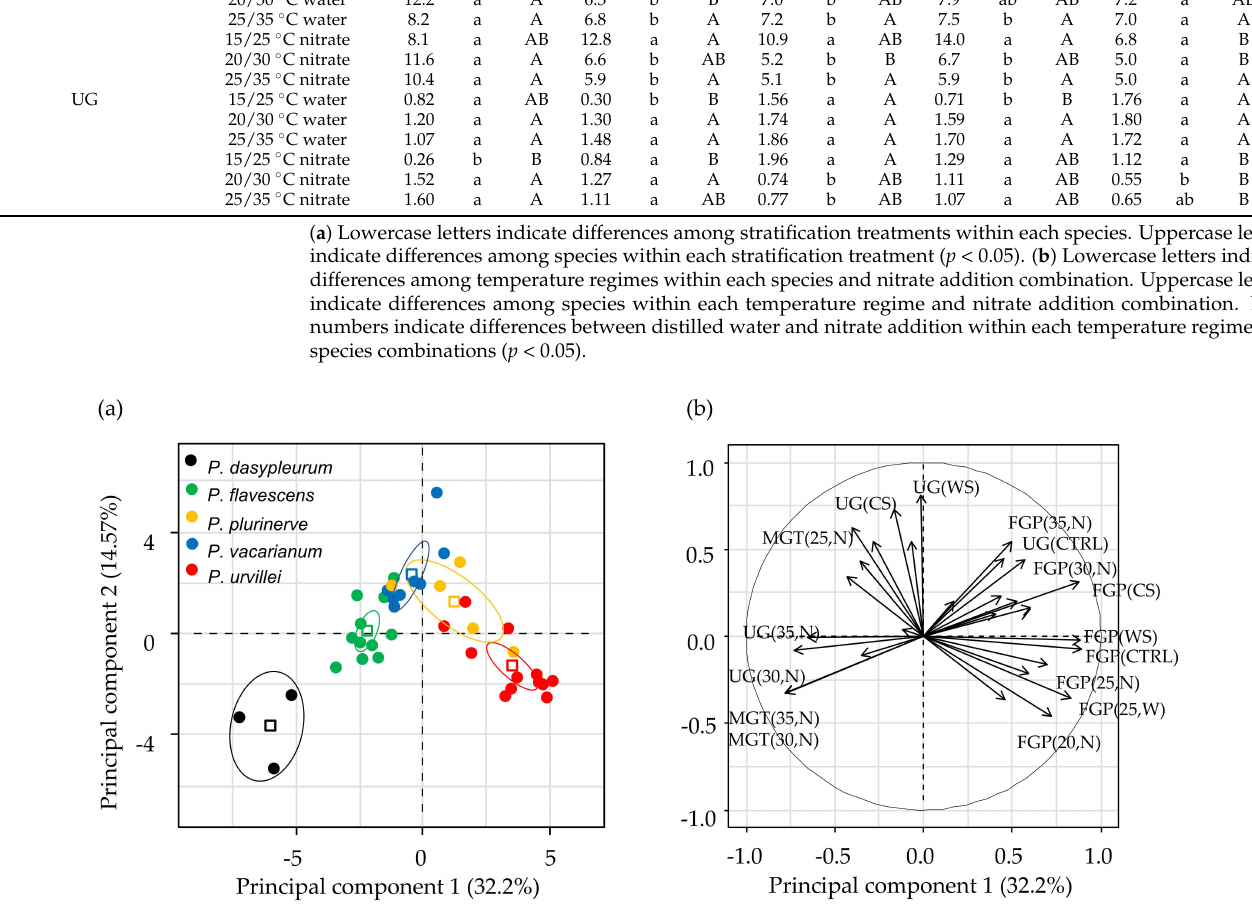
Figure A2. Principal component analysis using germination results (FGP, MGT or MGS and UG) of each treatment level of both germination experiments. ( a ) Each point is a genotype-by-harvest time score. Different colours identified species (see label). Also, the species mean score (squares) and the 95% confidence ellipses are shown. ( b ) Germination variables biplot, where the germination variables